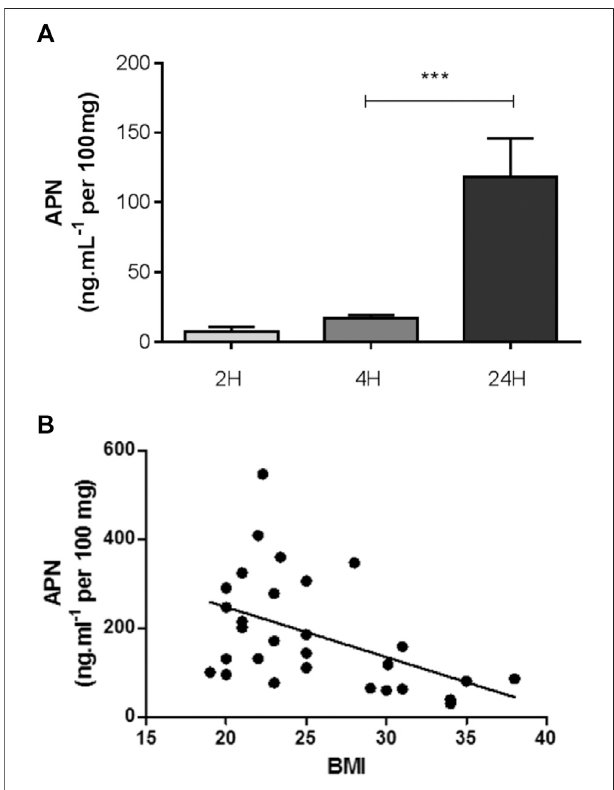
FIGURE 2 | APN release from lung explants. (A) Time-course of APN release from nonstimulated human lung explants cultured for 2, 4 and 24 h. Data are reported as the mean ± SEM of 5 – 11 independent experiments (***: p < 0.001). (B) Relationship between the APN production from unstimulated human lung explants after 24 h incubation assessed as the concentration in the supernantants and the donor ’ s BMI (n (cid:2) 30). Spearman ’ s correlation coef fi cient r (cid:2) -0.48; p (cid:2)